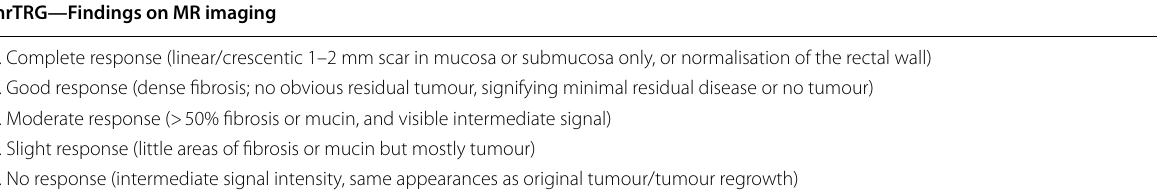
Table 2 mrTRG and corresponding MR imaging findings [23] mrTRG—Findings on MR